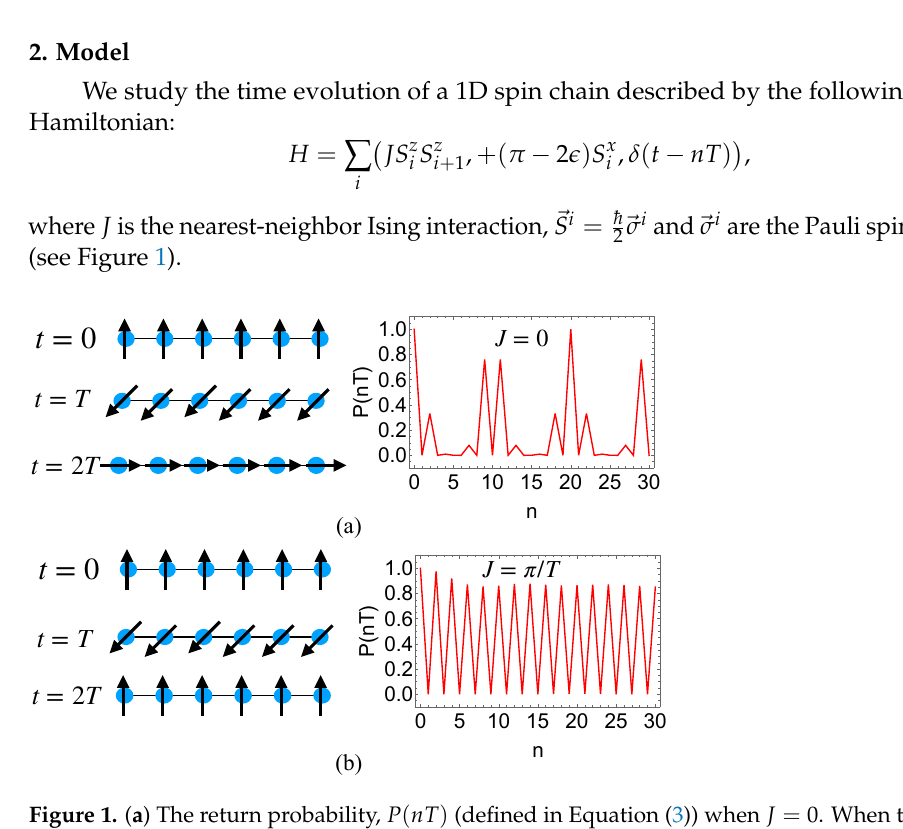
Figure 1. ( a ) The return probability, P ( nT ) (defined in Equation (3)) when J = 0. When the π pulse is imperfect, then there is no oscillation of the order parameter and hence no time crystal. ( b ) The return probability, P ( nT ) when JT = π for the nearest-neighbor Ising model. This example clearly shows that persistent time crystal order can be established in a disorder free spin chain by tuning the interaction